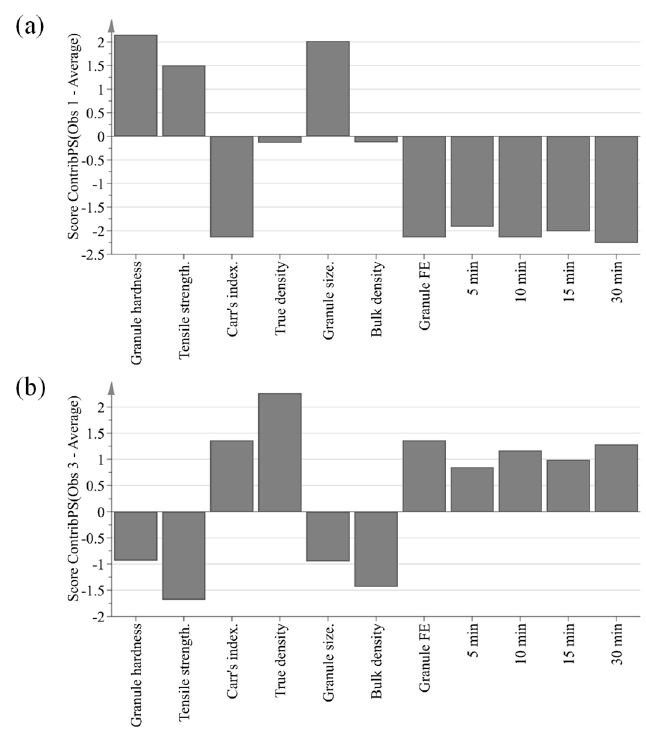
Figure 7. Score contribution plots showing variables contributing to the difference between run order 1 ( a ) or run order 3 ( b ) and the average of all run orders.